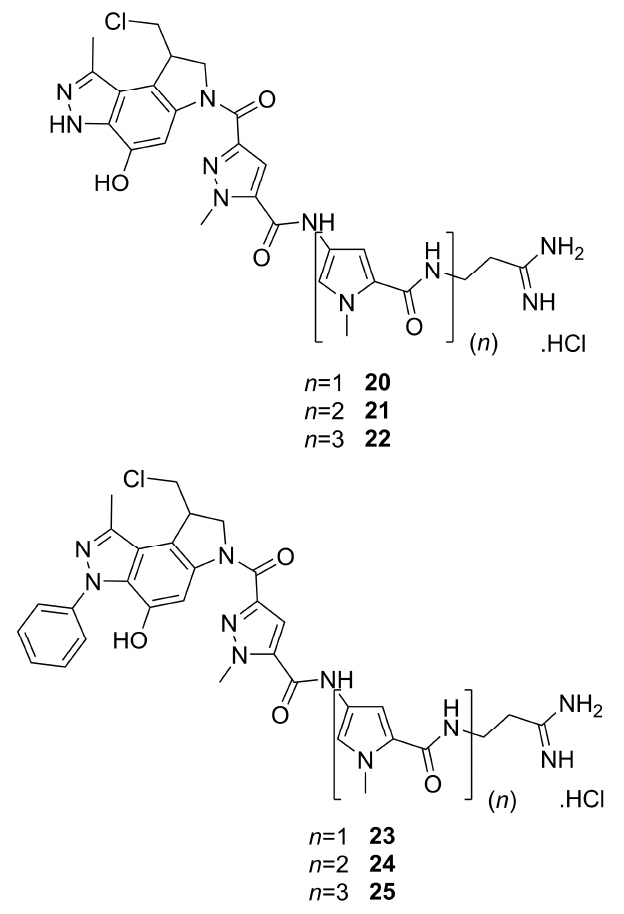
Figure 8. The six most active compounds from a family of pyrazole analogues of distamycin A with DNA alkylating activity [43].